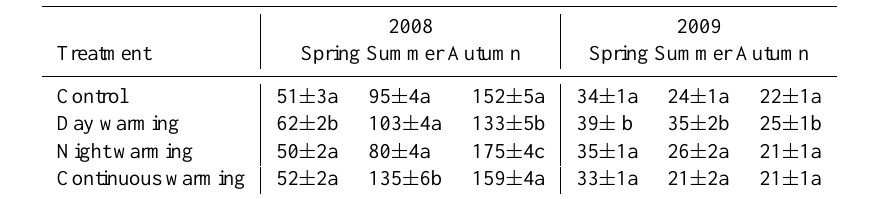
Table 2. Longevity of roots born in spring, summer and autumn in different treatments during the growing seasons of 2008 and 2009 (mean ± standard error). The Kaplan–Meier method was used to estimate mean lifespan. Longevity differences between different treatments were compared using Log-rank test. In each vertical row, the values with same superscript letters are not significantly different from each other at P =0.05.